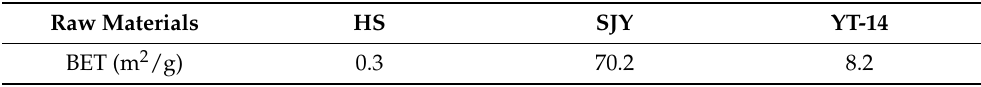
Figure 3. Particle size distribution of the experimental raw materials. Table 3. Specific surface area of the experimental raw